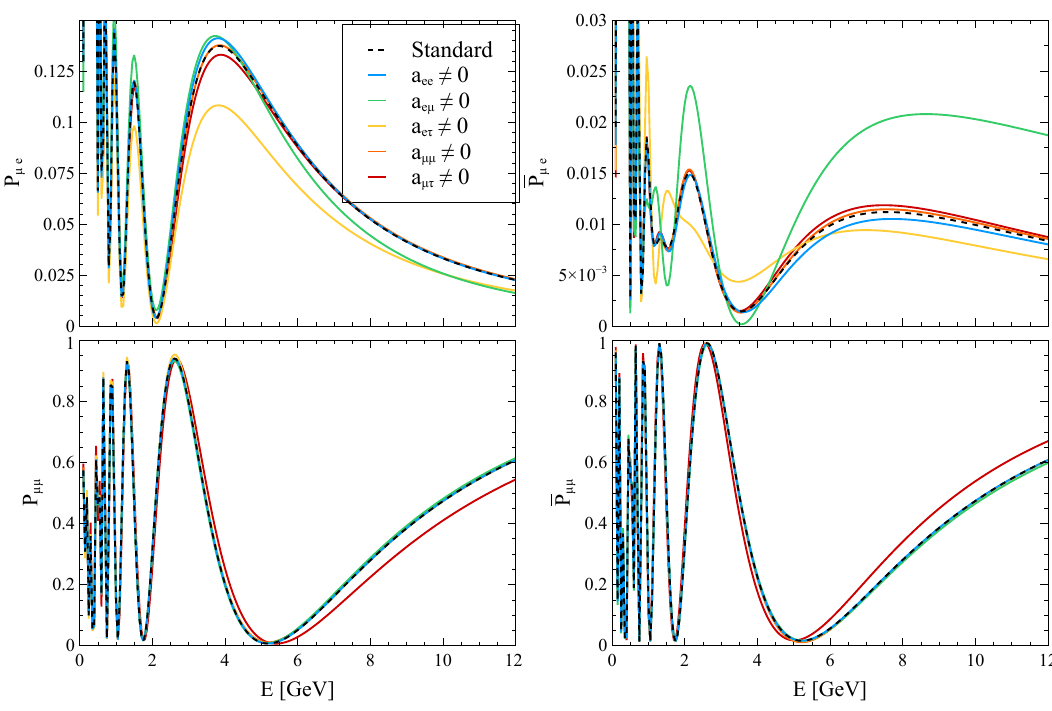
Figure 1 . The impact of individual LIV parameters on oscillation probability at the P2O baseline of 2595 km. The top (bottom) row shows the probability for appearance (disappearance) channel, while the left (right) column indicates the neutrino (anti-neutrino) mode. The black dotted curve shows the probability for the standard (no LIV) case, while the solid coloured curves are for individual LIV parameters present. The non-zero values of the individual LIV parameters a αβ was taken as 5 × 10 − 23 GeV, while the CP phase associated with the off-diagonal LIV parameters was taken as